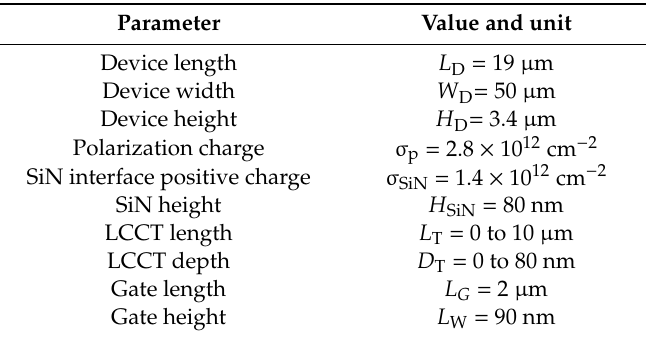
Table 1. Device specifications.